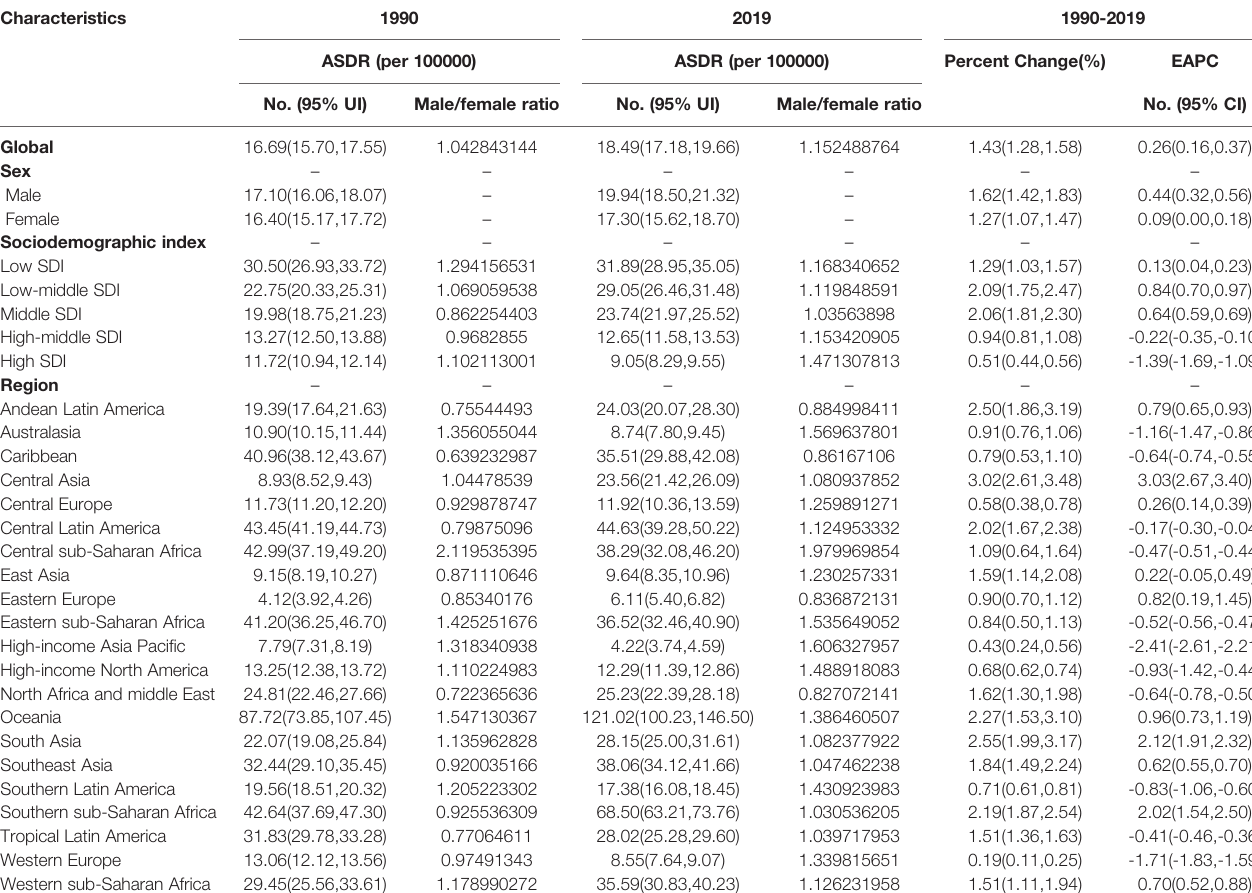
sexes, especially in people aged greater than 60 years ( Supplementary Figure 9A ). Globally, the male-to-female ratio peaked in the 30 – 34-year age group ( Supplementary Figure 6A ). In addition, the EAPC in the age-standardized death rate due to T2DM was positively correlated with the age- standardized death rate ( r = 0.073, P = 0.299, Supplementary Figure 3C ) and negatively correlated with the SDI value ( r = − 0.370, P =0.001, Supplementary Figure 3D